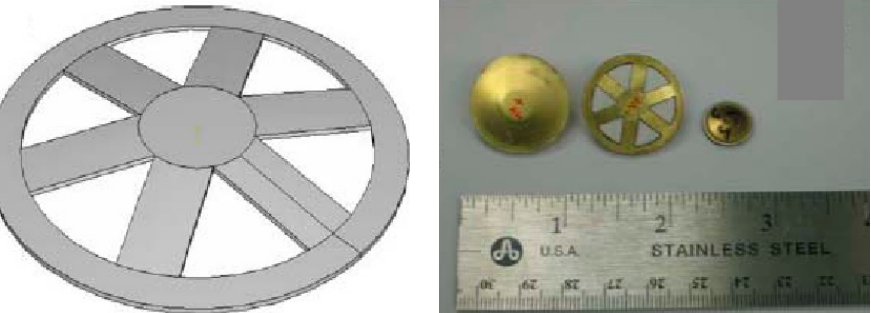
Figure 18. Hub cymbal transducer.